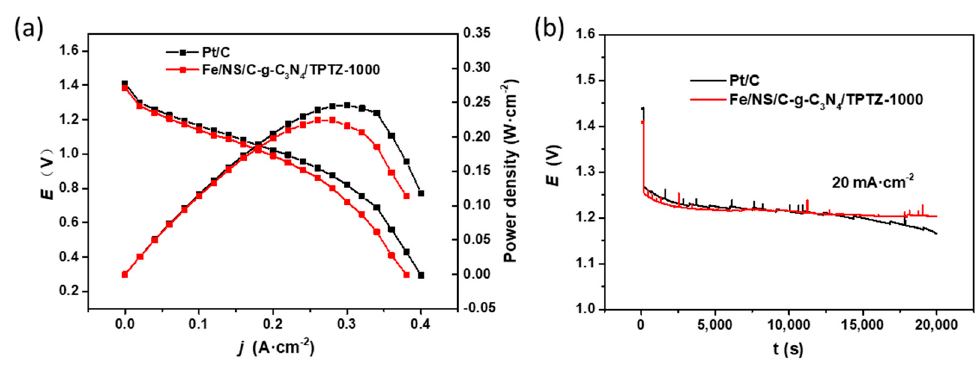
Figure 8. ( a ) Polarization curve s and ( b ) discharge curves of Zn ‐ air batteries with Fe/NS/C ‐ g ‐ C 3 N 4 /TPTZ ‐ 1000, and 20 wt% Pt/C as cathode catalysts at 298